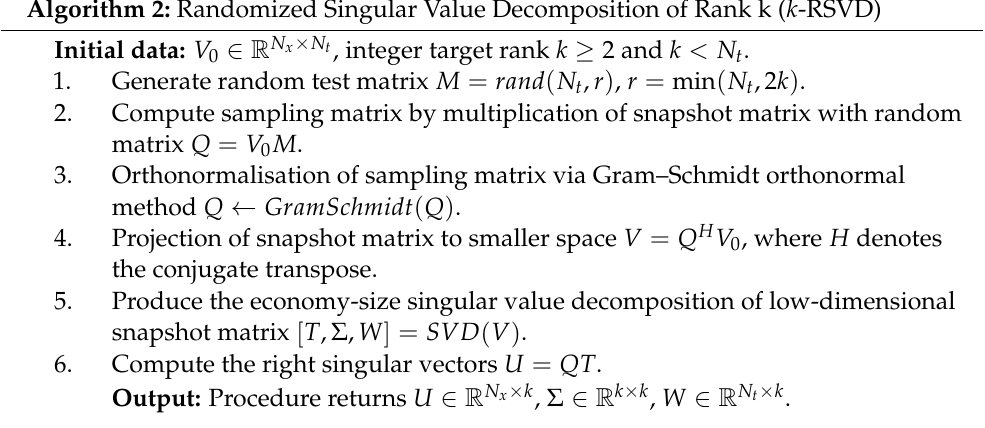
Algorithm 2: Randomized Singular Value Decomposition of Rank k ( k